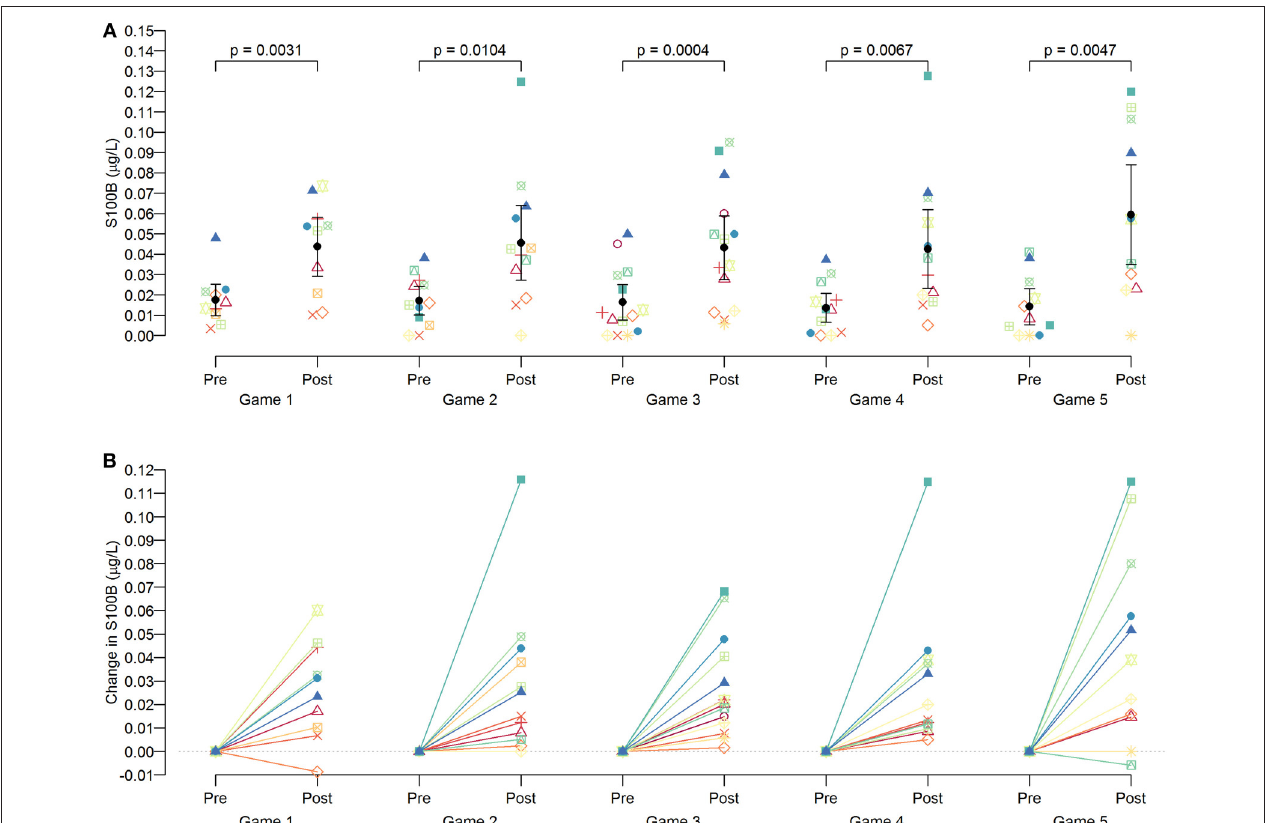
FIGURE 2 | Pattern of S100B changes in players per game. Serum S100B levels were measured at pre-games (4–5h prior to the game) and post-games (within 1h from the end of the game). As a group, significant increases ( p < 0.05 for all games) were observed at post-games compared to the S100B levels of pre-games (A) , but an individual pattern showed heterogeneous magnitudes of increase (B)